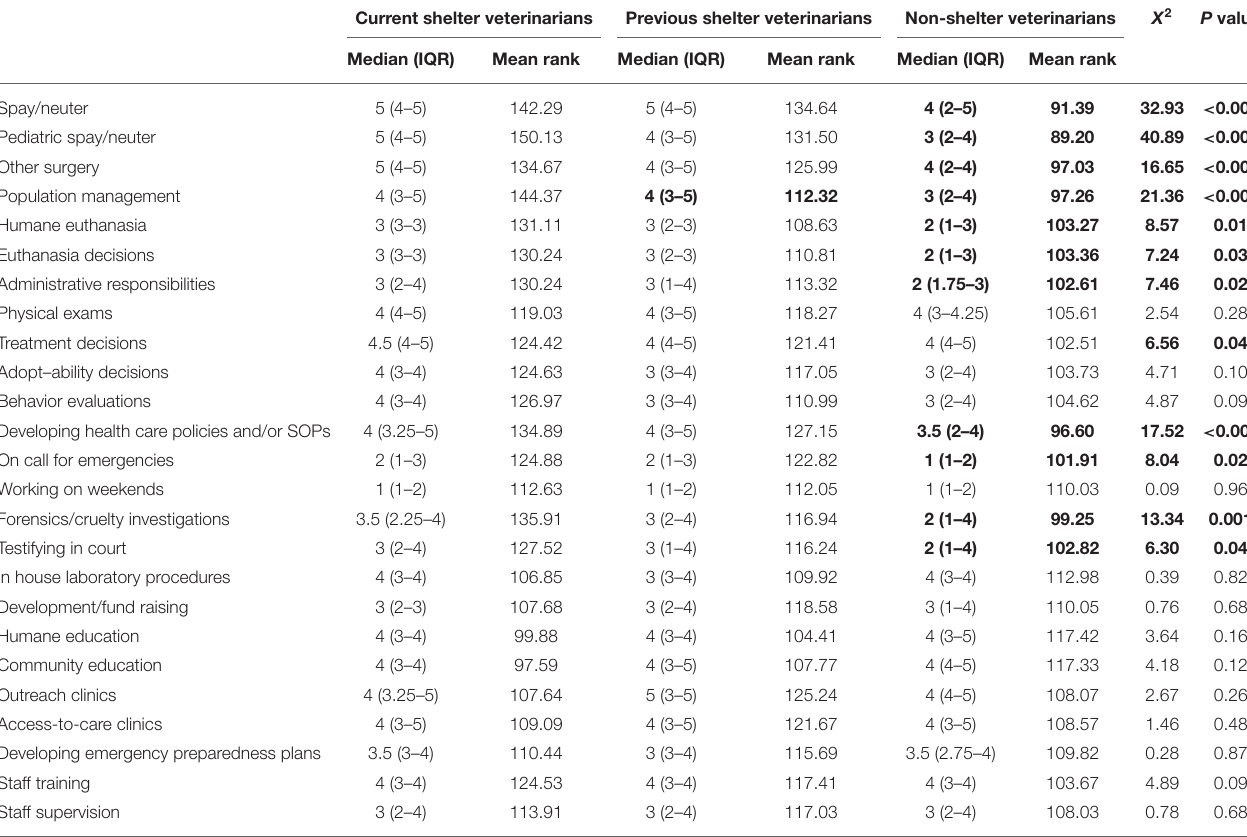
TABLE 2 | Kruskal-Wallis tests describing differences in appeal of duties of shelter medicine between current, previous and non-shelter